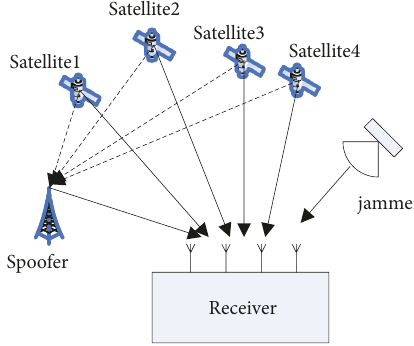
Figure 1: Severe environment with the spoofing and jamming